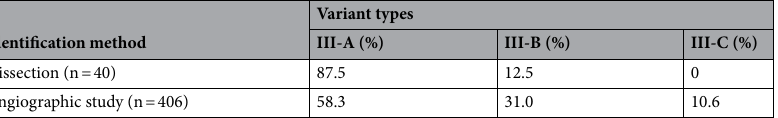
Table 4. Percentage of type III subtype variants between dissection and angiographic studies. The comparison data of type III and its subtypes from (Table 3), the percentage of each variant is compared between dissection and angiographic studies in type III-B and type III-C. The mean percentage of type III-B and type III-C in cadaveric dissection studies compared to angiographic studies are statistically significantly different. To illustrate, the mean percentage of type III-B are 12.5% and 31.0% in the cadaveric study and angiographic study, respectively (independent t-test, p = 0.015). Type III-C is in the same manner with 0% and 10.6% in the cadaveric study and angiographic studies, respectively (independent t-test, p = 0.009)).